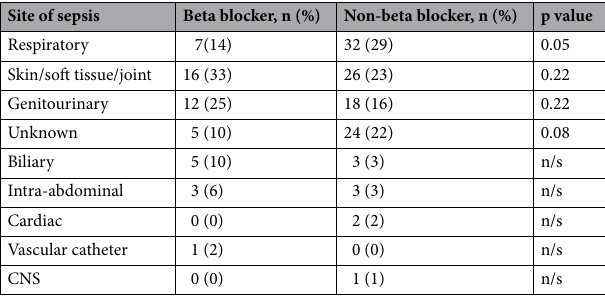
Table 2. Site of sepsis by group.